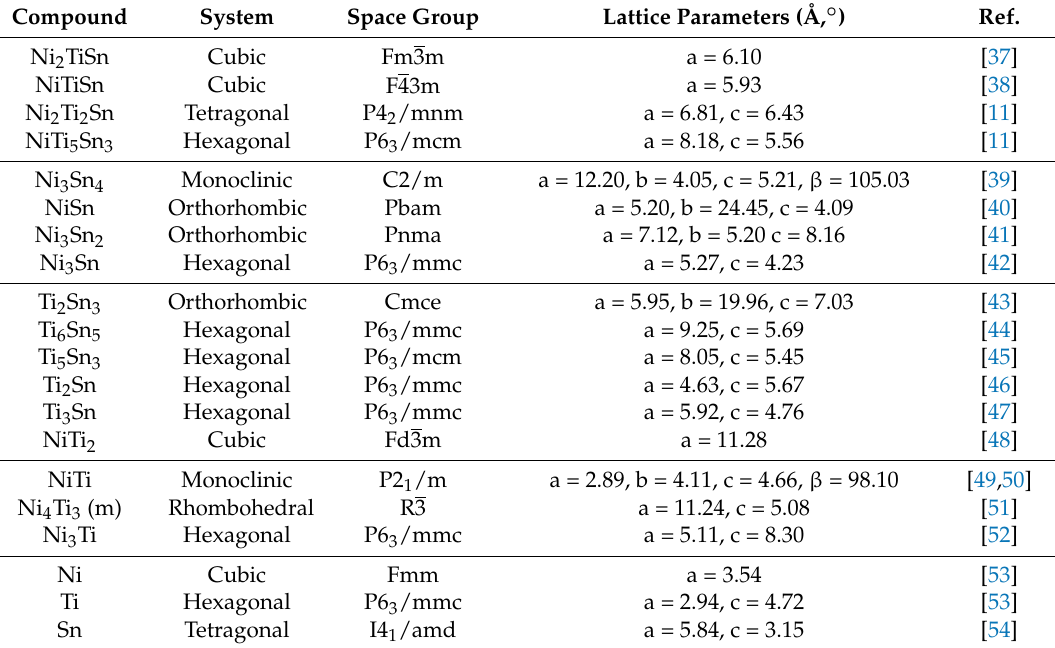
Table 1. Crystallographic data for elements and compounds in the Ni-Ti-Sn system.